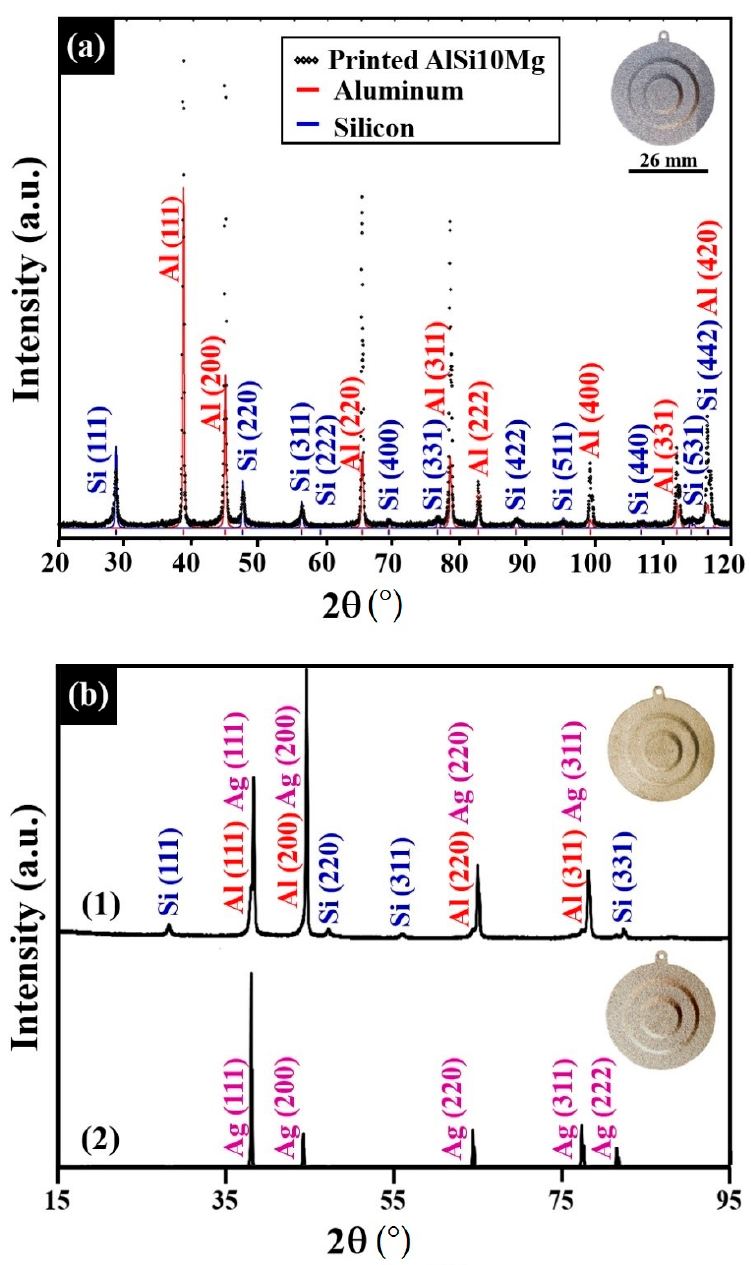
Figure 5. XRD patterns of the: ( a ) as-printed AM-LPBF AlSi10Mg substrate; ( b ) AlSi10Mg disk- shaped specimens coated with laboratory-developed silver (Ag thickness of ≈ 1 µm, Graph 1) and commercial coating (Ag thickness ≈ 16 µm, Graph 2).